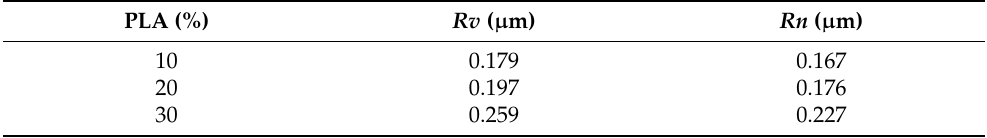
Table 5. Two average radii for blends with different PLA contents. PLA